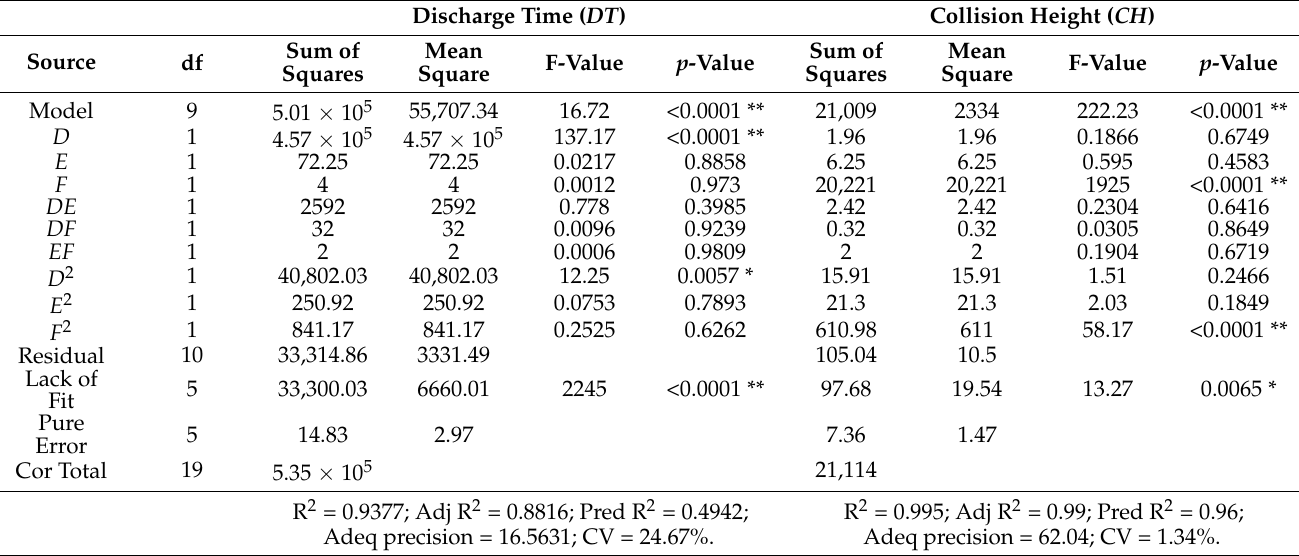
Table 9. ANOVA of the results of the discharge-drop test.